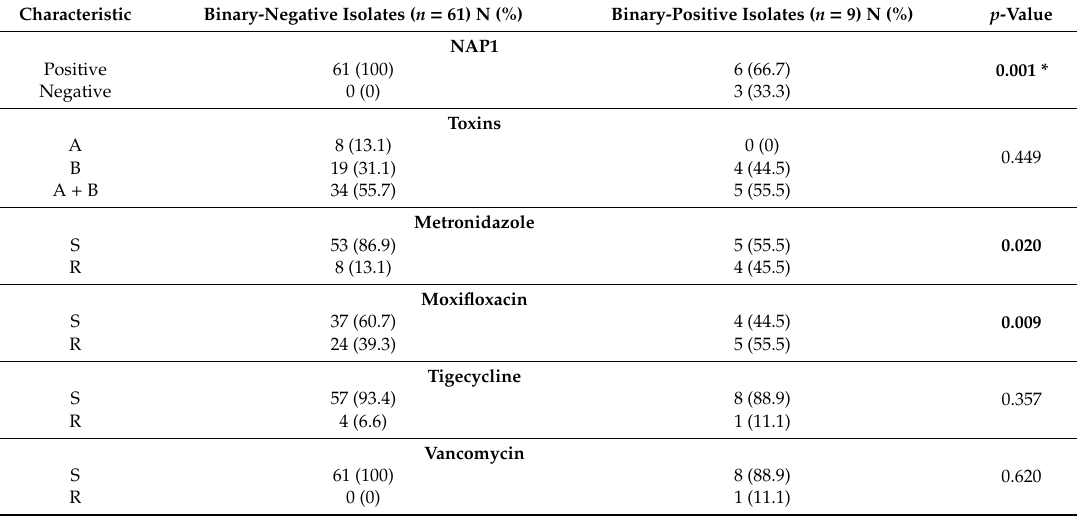
* Bold values indicate statistical significance.